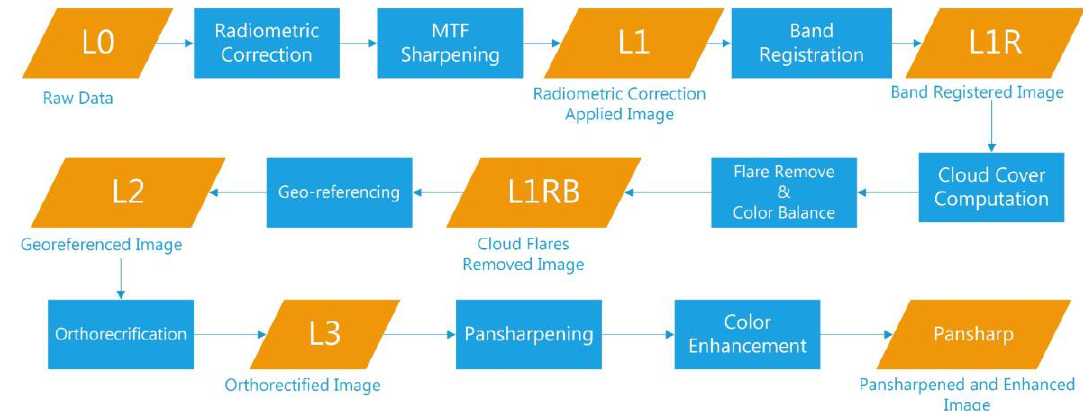
Figure 4. Image Processing